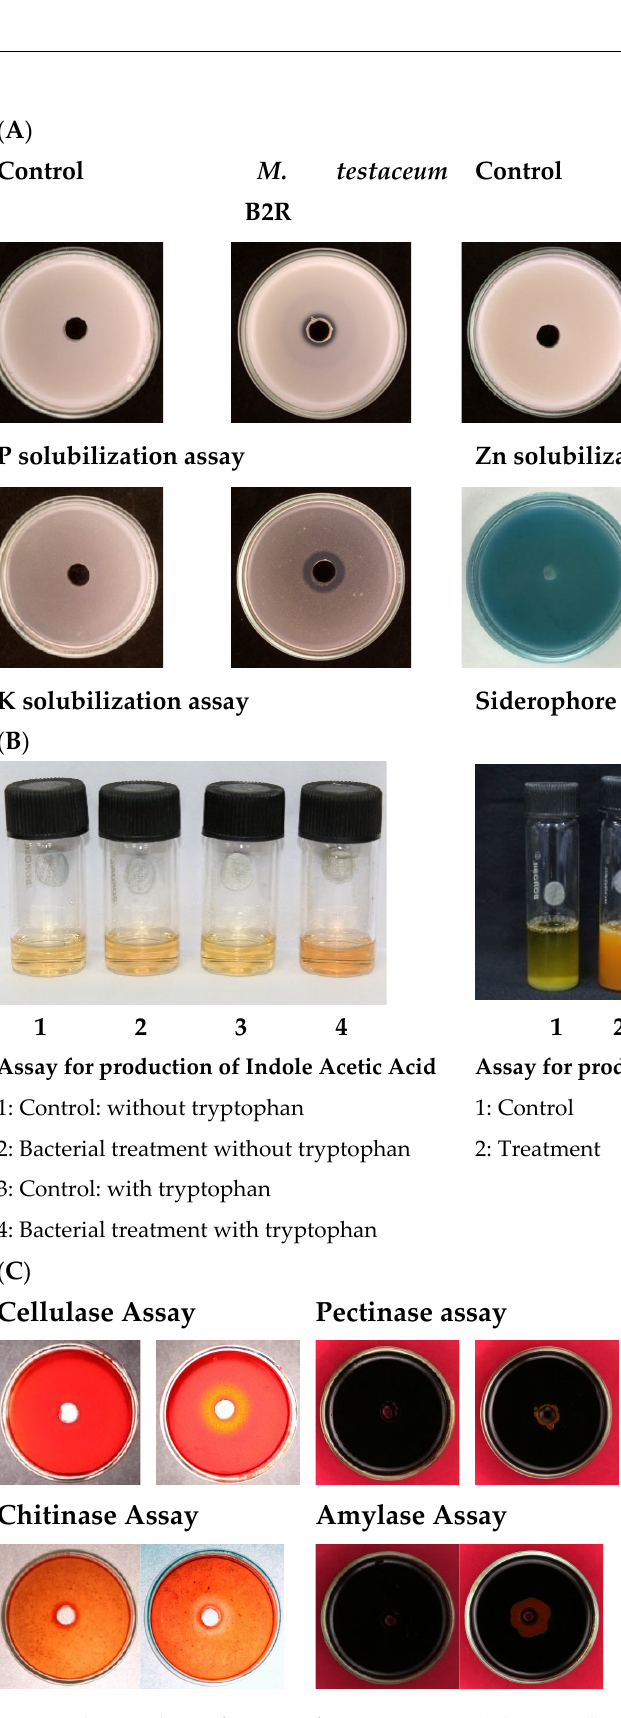
Figure 4. Plant probiotic features of M. testaceum B2 ( A ) Mineral solubilization assays. ( B ) Production of IAA and Ammonia. ( C ) Production of hydrolytic enzymes.